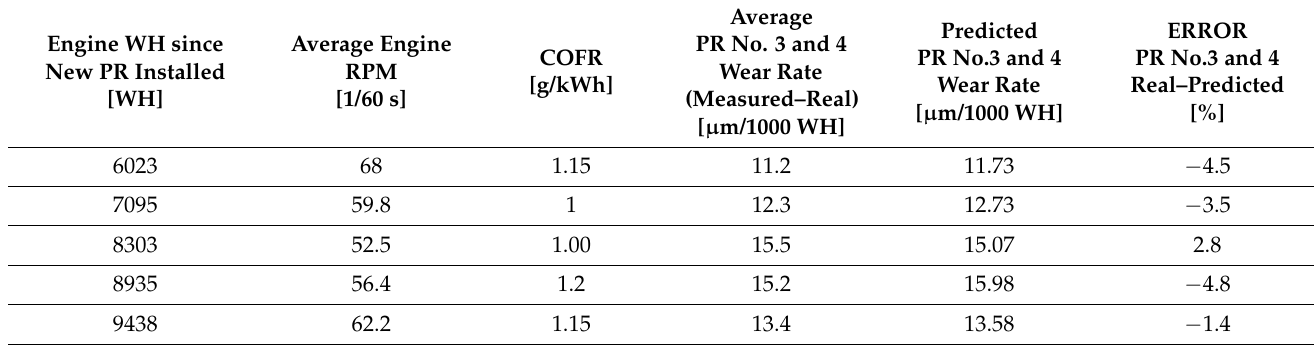
Table 6. Results of the PR wear ratio prediction model verification obtained for PR No.3 and